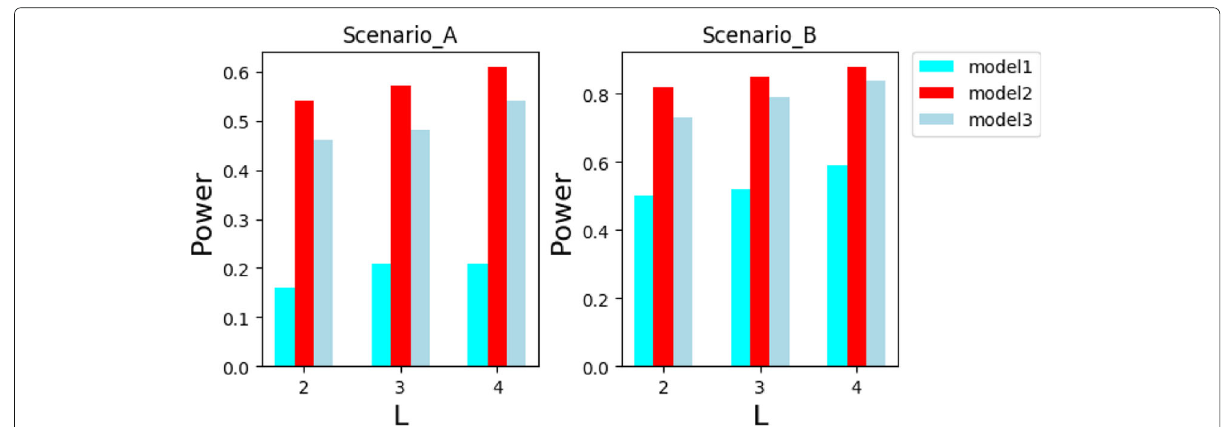
Fig. 1 020301( MAF = 0.2, λ = 0.3, r 2 =